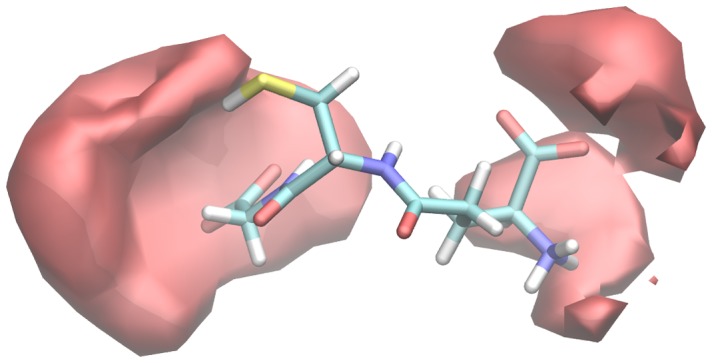
The volumetric map was created for the radical (OH•) occurrence around those 838 structures where the OH• interacts with at least two heavy atoms of the GSH.